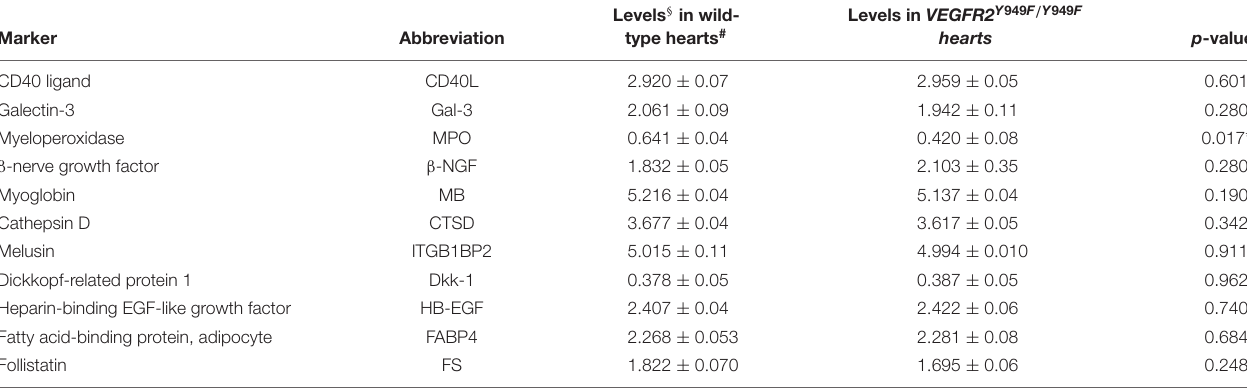
TABLE 1 | Expression of inflammatory markers estimated from Proseek Multiplex CVDI assay on heart lysates after myocardial infarction.